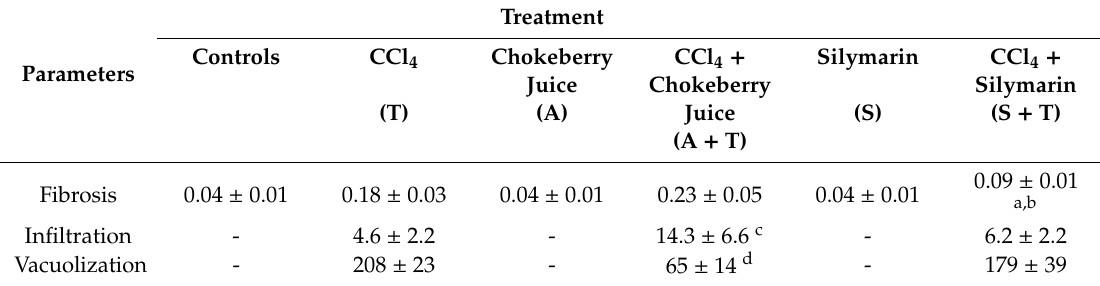
Table 3. E ff ect of chokeberry juice or silymarin on the level of liver fibrosis, lymphocyte infiltration, and density of vacuolated